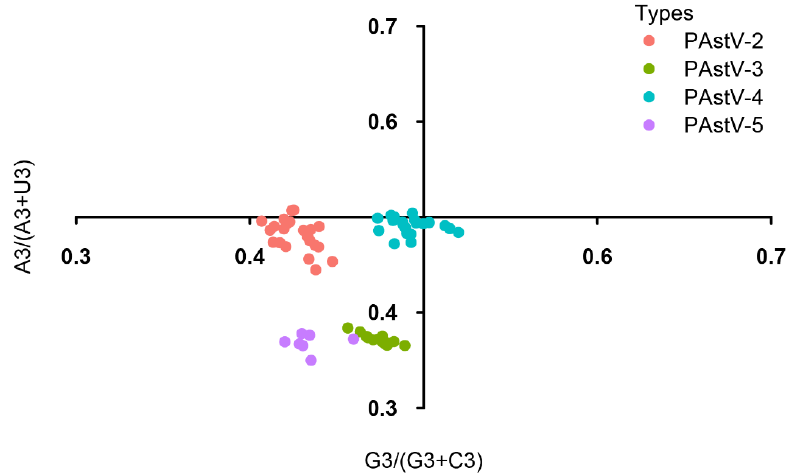
Figure 4. PR2 plot analysis of the PAstV complete coding genomes. PAstV-2, PAstV-3, PAstV-4, and PAstV-5 strains are represented in orange, green, blue, and purple, respectively.